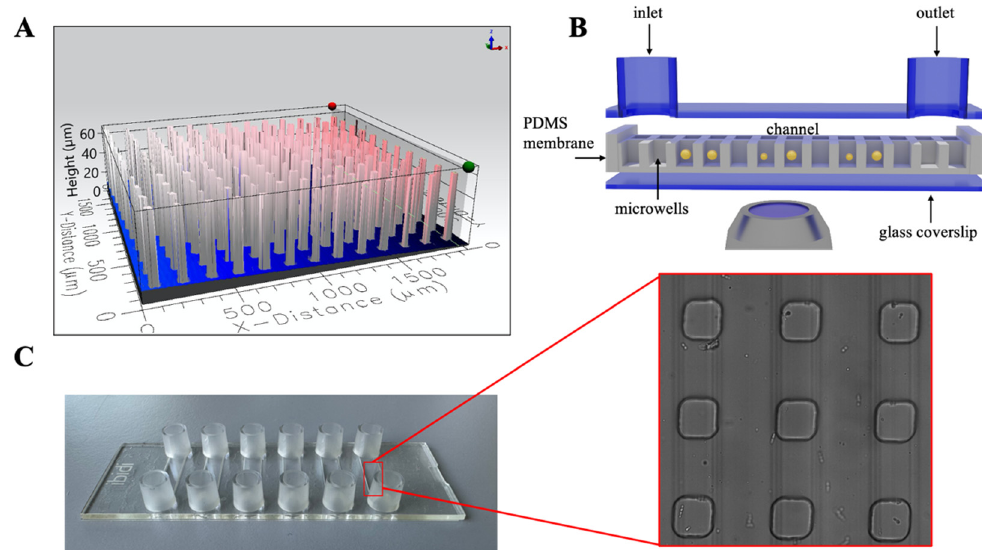
Figure 2. ( A ) Dimensions of a 3D model of the SU8 mould with pillars (3-D pro fi lometer). ( B ) Schematic cross-section of the assembled micro fl uidic chip fi lled with yeast cells (yellow dots) ( C ) Picture of the complete micro fl uidic chip and bright- fi eld image of the microwells fi lled with cells.